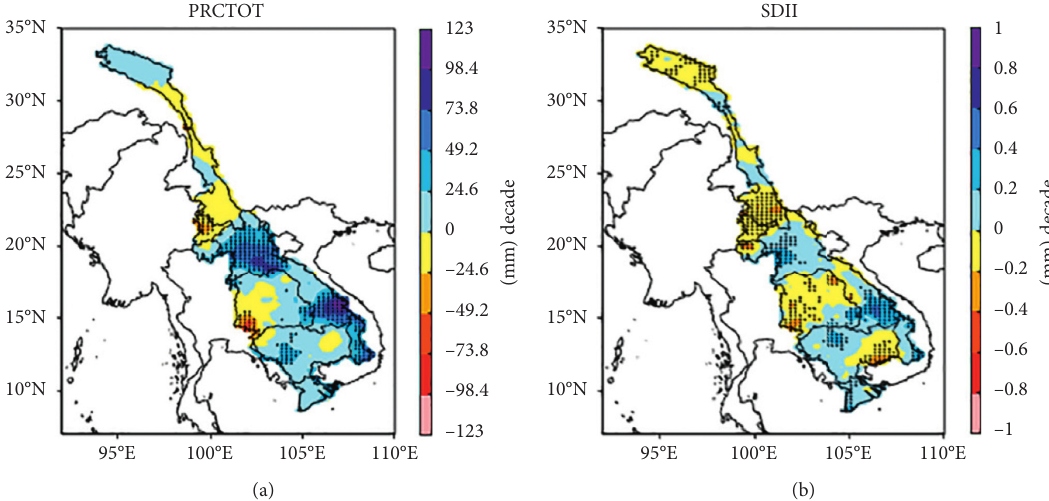
Figure 8: Spatial distribution of trend in PRCTOTand SDII in the MB over 1951–2015. The black dots indicate that the trend in the grid is significant ( p < 0 . 05) under the Mann-Kendall test.